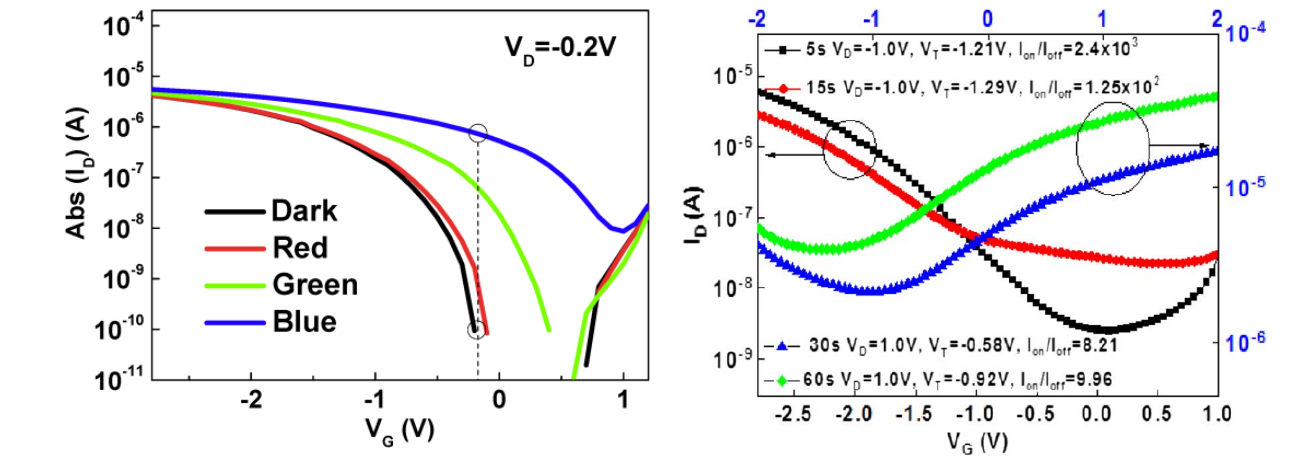
Figure 12: Transfer characteristics of the p-type SnO TFT in the dark and under light illumination at RGB wavelengths [70]